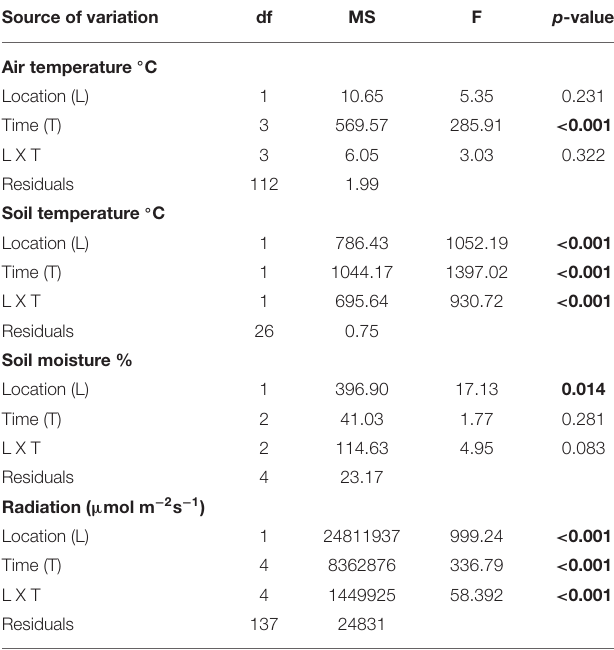
TABLE 2 | Repeated measures ANOVAs of microclimatic variables (air temperature, soil temperature, moisture, and